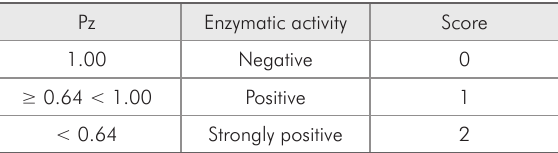
Table 1 - Enzymatic activity according to Pz value and score attributed (Price et al. , 14 with modifications).